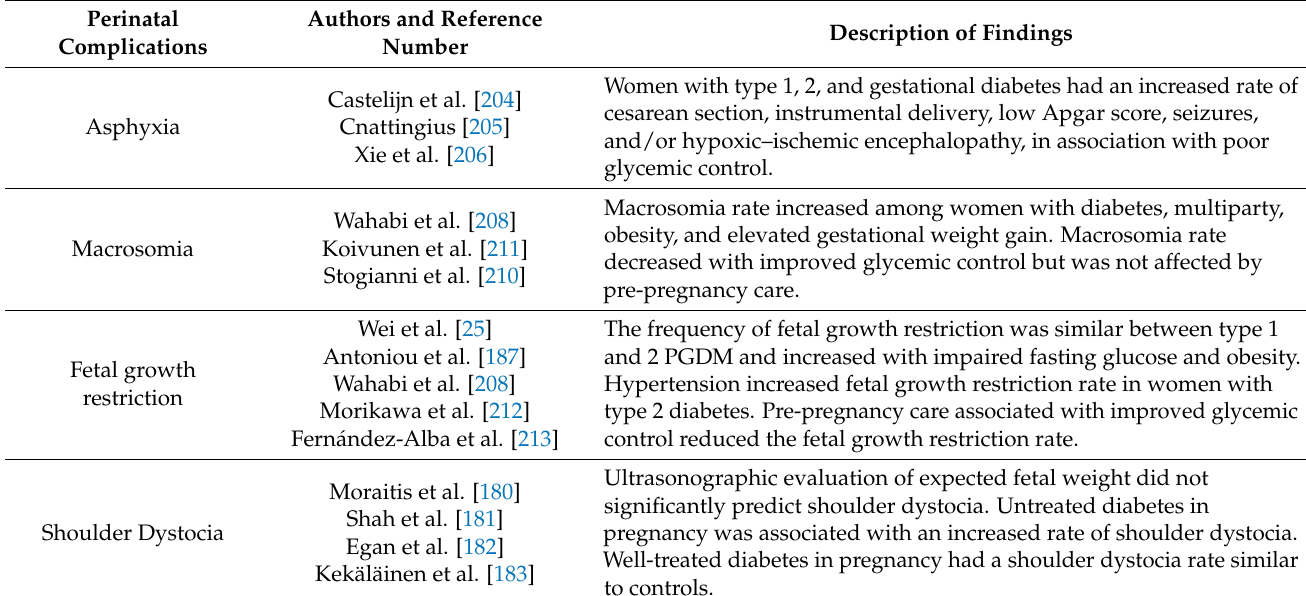
Table 3. The effects of diabetes in pregnancy on the newborn